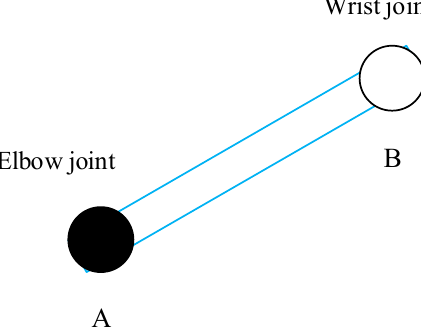
Figure 2. Schematic diagram of the error joint and its parent joint.